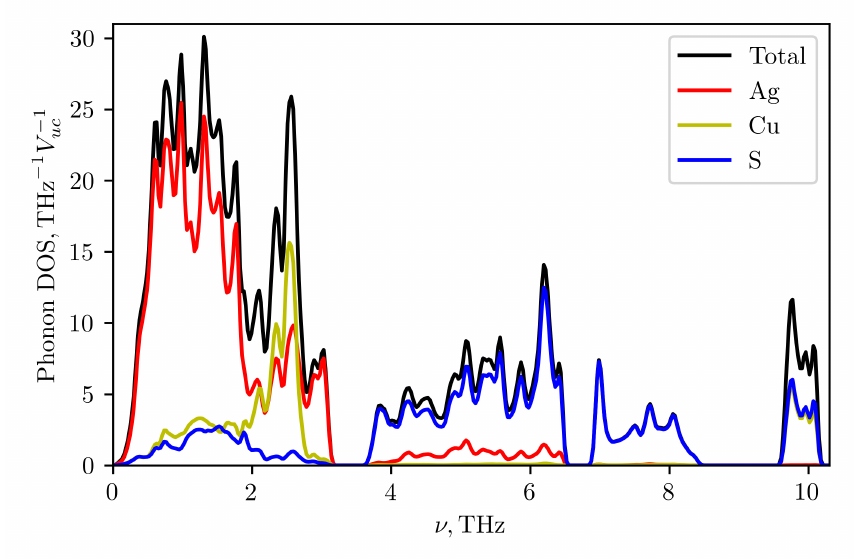
Figure 14. Total and atom-projected phonon density of states in Ag 3 CuS 2 (I4 1 /amd) calculated at room